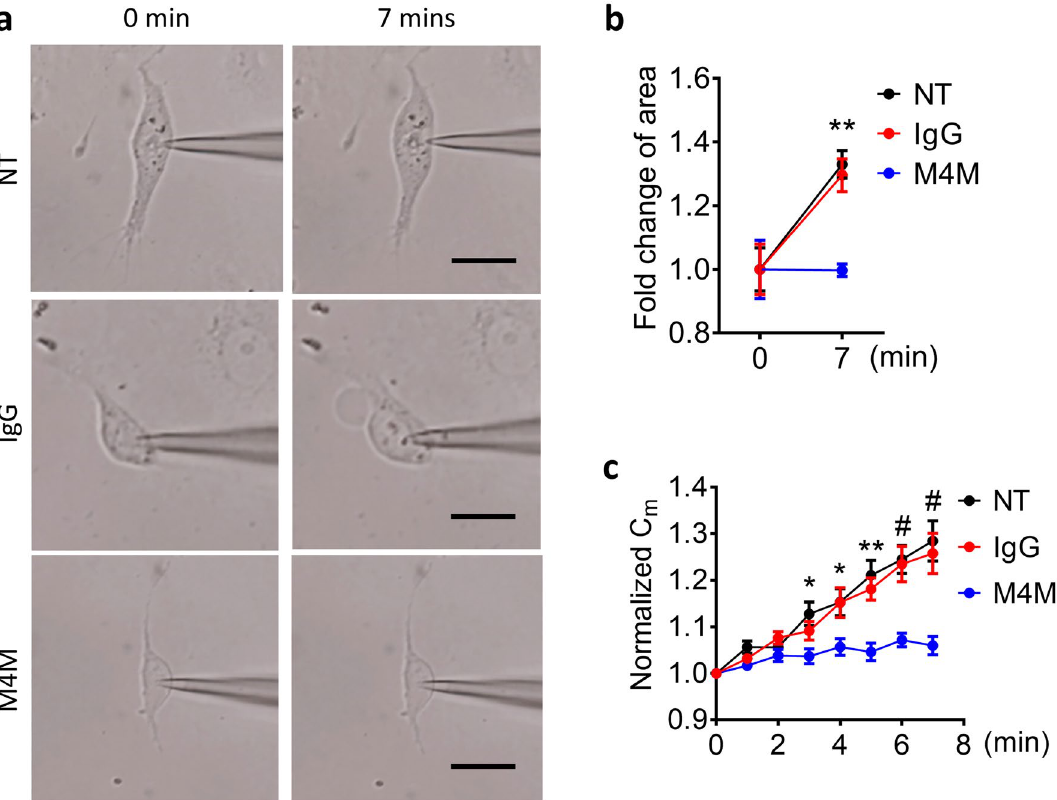
Figure 5. M4M prevents hypoxia-induced cell swelling in HBMECs. ( a ) Sample images of HBMECs before and after 7-min hypoxia treatment. HBMECs were pre-treated with control mouse IgG or M4M at a concentration of 20.8 μg/mL for 30 min. NT: non-treated. Scale bars: 10 µm. ( b ) Summary of cell areas. n = 8 for IgG and n = 7 for NT and M4M. ( c ) Time course of normalized membrane capacitance (Cm) under 7-min hypoxic induction. n = 9 cells for NT; Control mouse IgG: n = 8 cells; M4M: n = 9 cells. Statistical analysis in ( b,c ) were performed using Two-way ANOVA with Bonferroni’s post hoc test. *p < 0.05, **p < 0.01, # p < 0.0001 for M4M vs IgG or